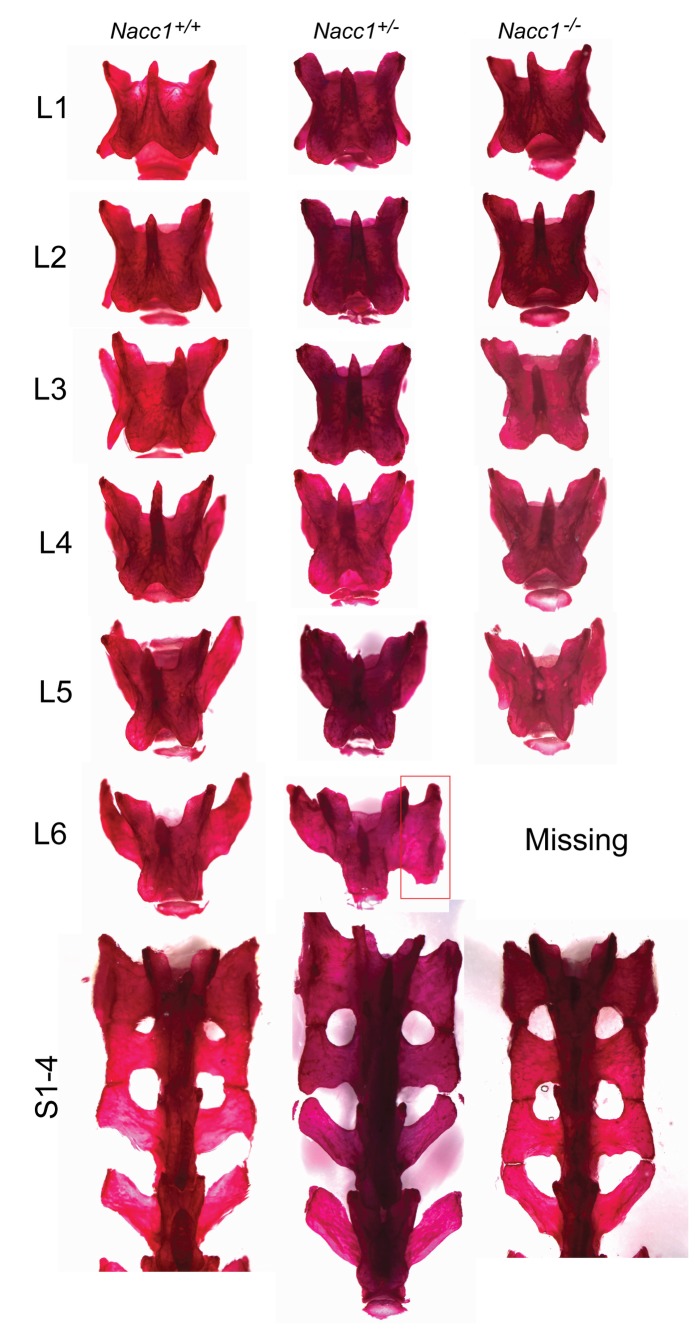
Reduced NAC1 expression ablates or changes the conformation of the sixth lumbar vertebra 6 (L6).Comparison of representative Alizarin red-stained lumbar (L) and sacral (S) vertebrae of adult Nacc1+/+ (wild type), Nacc1+/- (heterozygous), and Nacc1-/- (knockout) mice. In the Nacc1-/- animal, L6 is missing, and the processes of all sacral vertebrae (S1-4) are fused; indeed, caudal extensions of the broad wings of S3 in this genotype resemble the profile of vertebra S2 rather than the usual contours of S3 in Nacc1+/+ mice. In the Nacc1+/- counterpart, L6 has undergone partial (unilateral) transformation into a sacral identity (“sacralization,” red box). The lumbar vertebrae were disarticulated to better showcase their characteristic shapes.